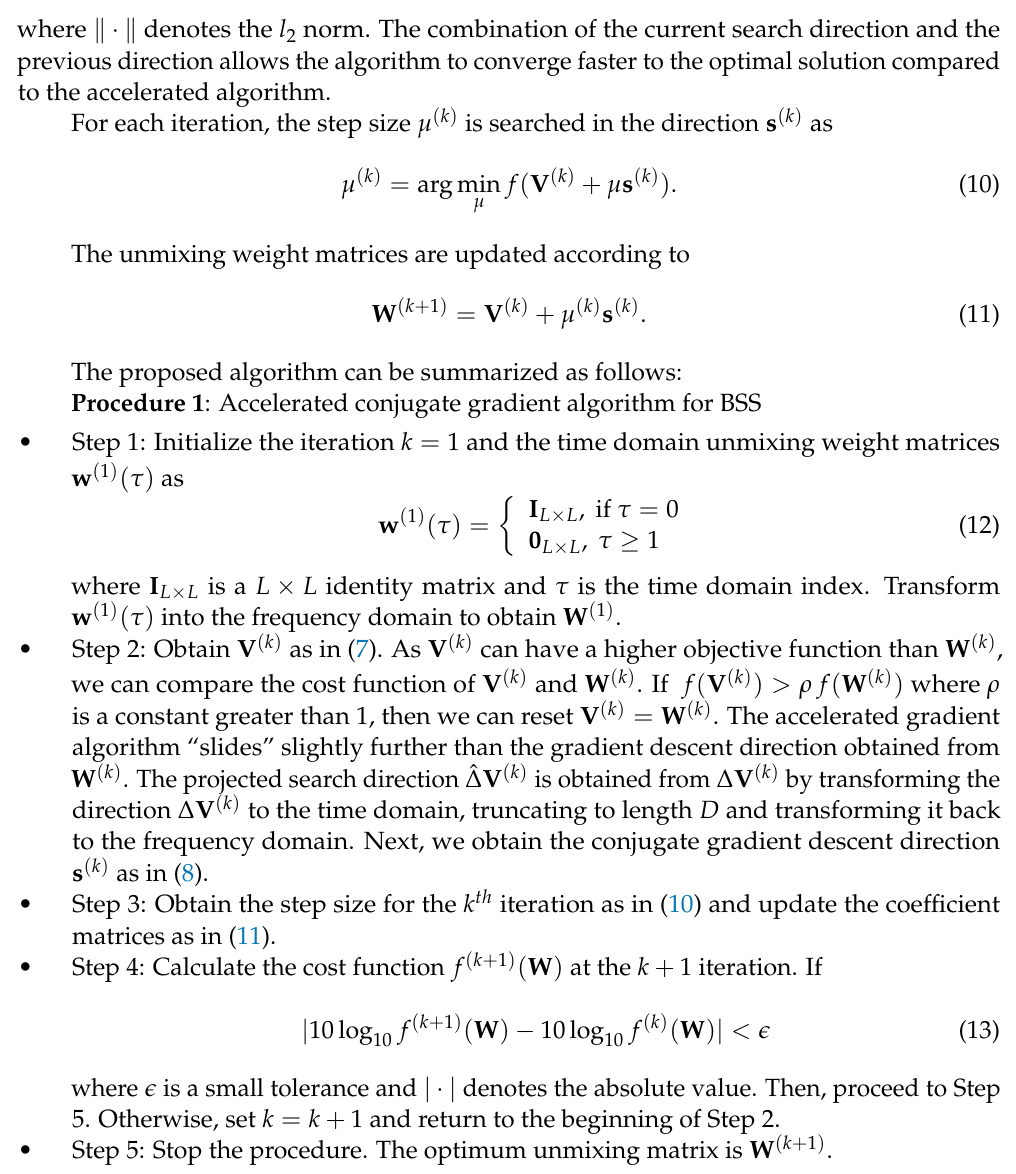
Procedure 1 : Accelerated conjugate gradient algorithm for